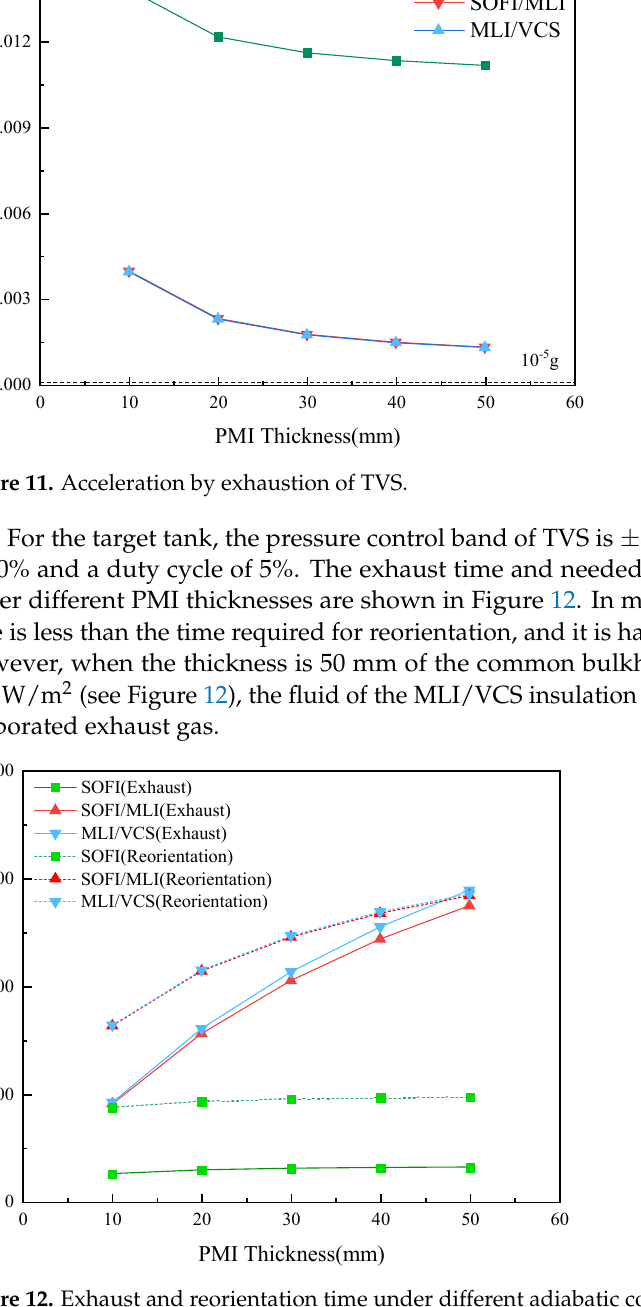
Figure 12. Exhaust and reorientation time under di ff erent adiabatic conditions.